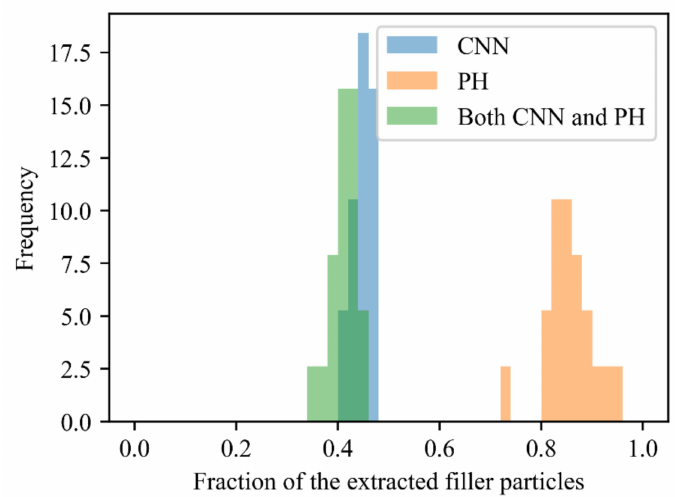
Figure 18. Fractions of the filler particles extracted by the PH and CNN that contributed to the positive example. Their values were computed as the ratios of the numbers of pixels of the extracted particles to the number of pixels for all filler particles. The blue bars denote the ratios of the filler particles extracted by CNN; the orange bars represent the PH results; and the green bars denote ratios of the filler particles common to the fillers extracted by CNN and the fillers extracted by